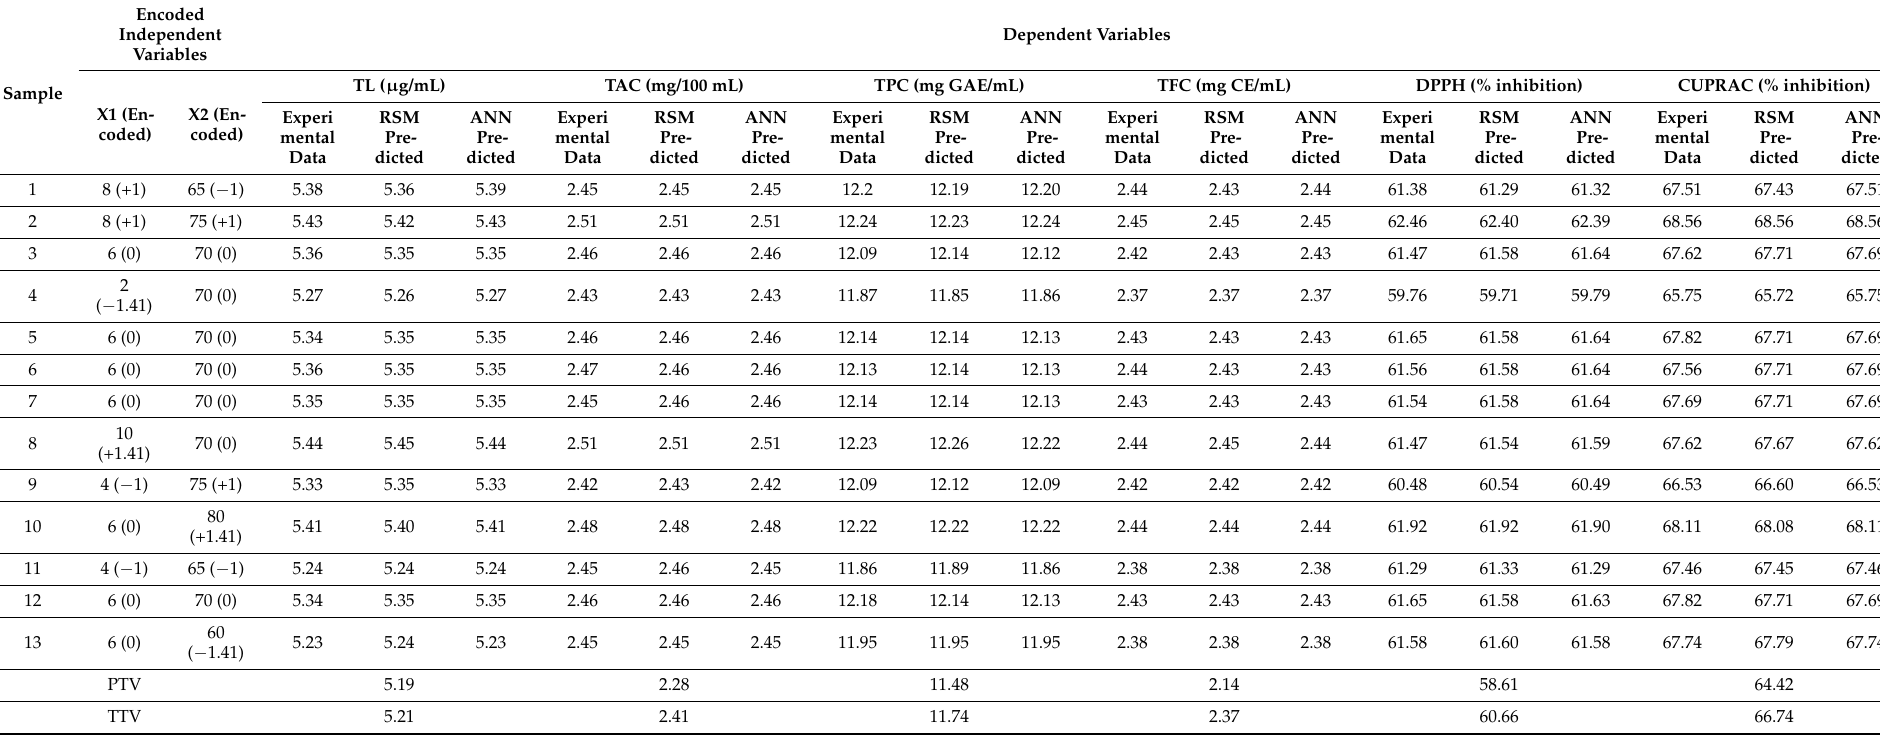
Table 2. Analysis of the effects of time and amplitude on bioactive components of TTV by RSM and